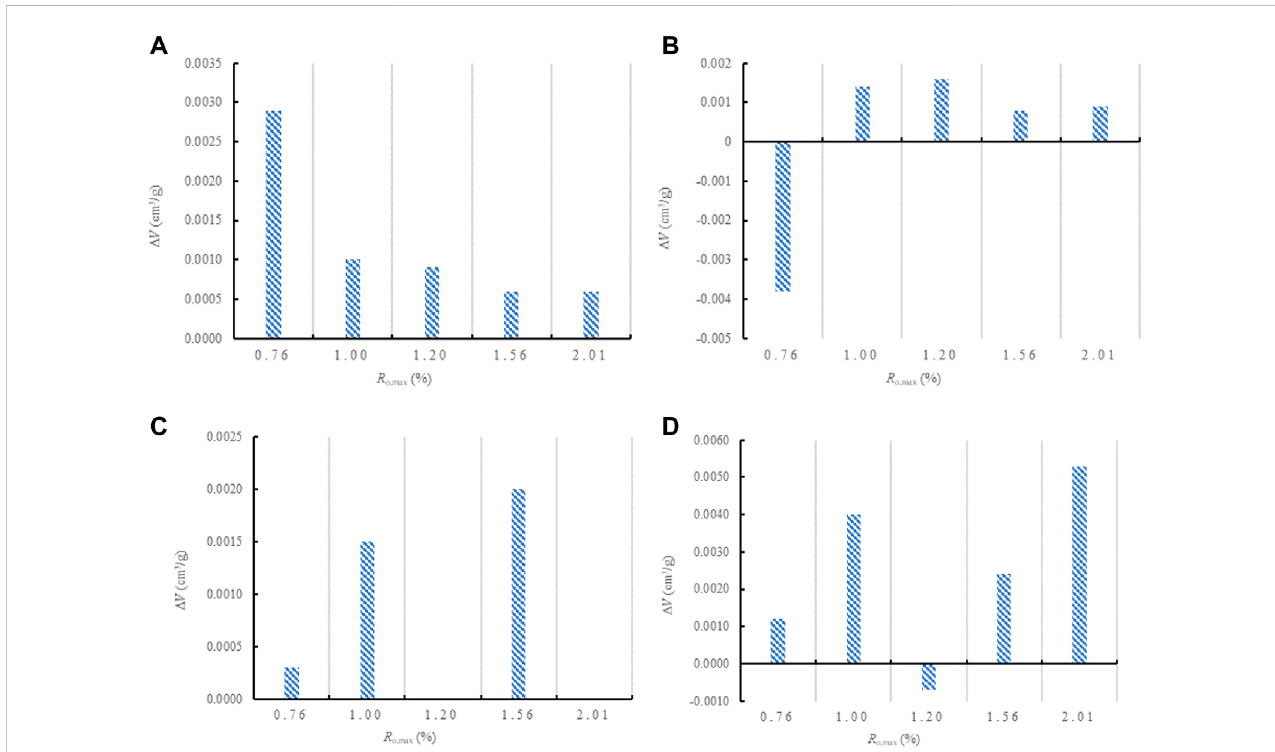
The changes in incremental pore volume of coal samples due to Sc-CO 2 extraction (A) Micropore; (B) Transitional pore; (C) Mesopore; and (D) Macropore.